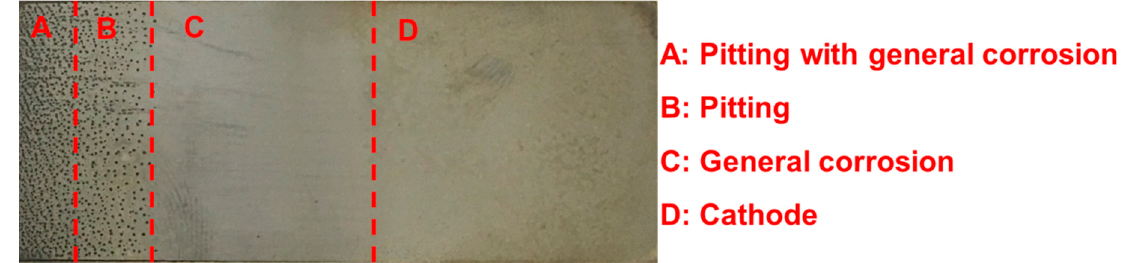
Figure 9. The surface appearance of the 50 mm long BPE after 30 min bipolar exposure.